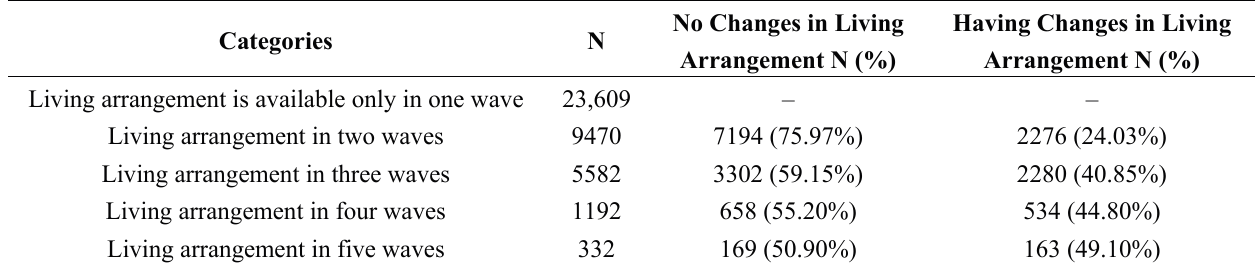
Table A2. Variation in living arrangement for five waves.